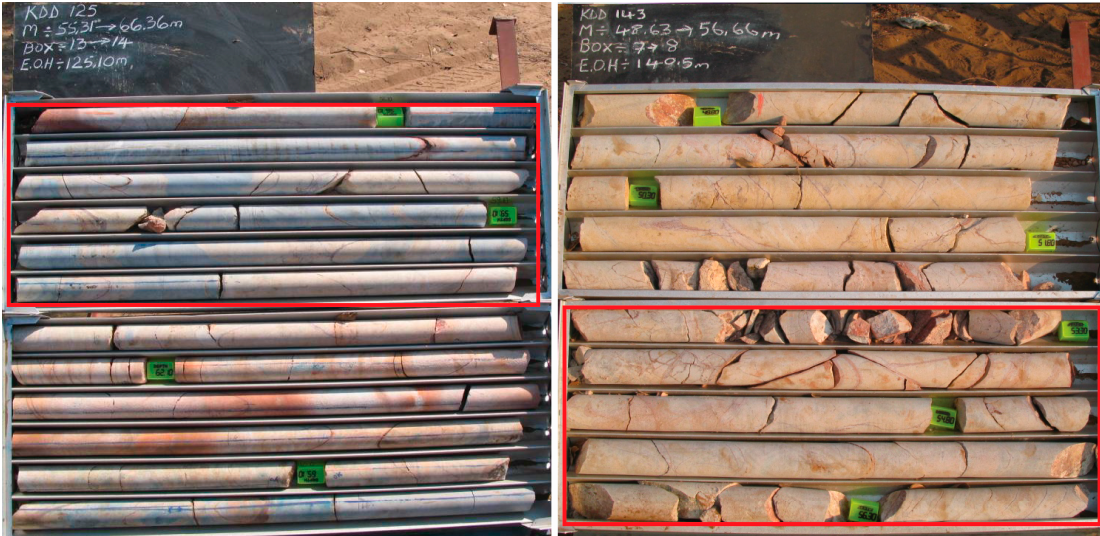
Figure 5. Pictures of drillcore trays with the analyzed drillcore intervals (enclosed in the red line): KDD 125: interval 55.00–60.90; and KDD 143: interval 50.00–54.93. In both the cores it is possible to see reddish intervals, affected by supergene alteration.